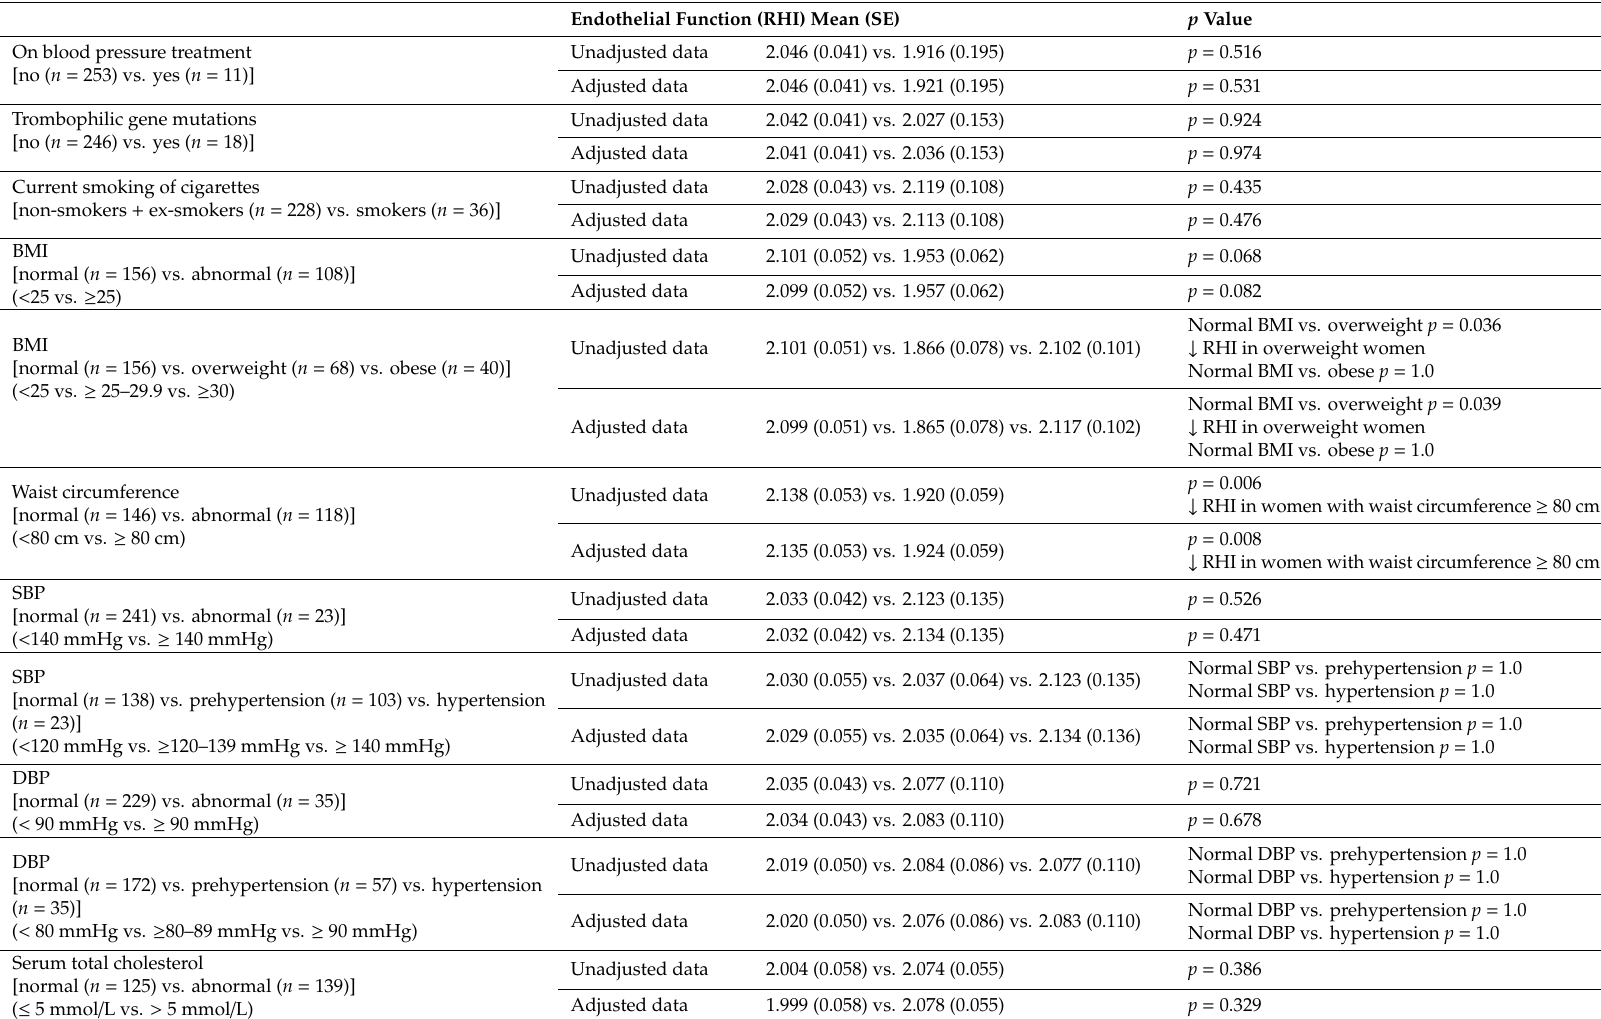
Table 1. Impact of classical cardiovascular risk factors and a history of pregnancy on vascular endothelial function_ overview (ANOVA, ANCOVA). Endothelial Function (RHI) Mean